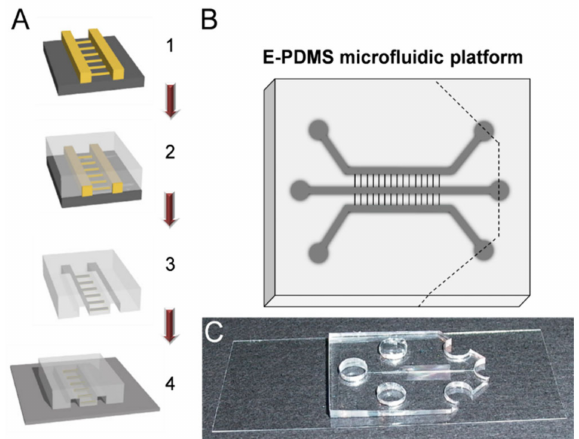
Figure 5. Process flow for fabrication and assembly of microfluidic devices for cell signaling studies. ( A ) Overview of fabrication and assembly process for microfluidic chambers (200 µ m W × 45 µ m H) for cell signaling. Step 1: Microfluidic masters are used for (step 2) replicate molding of PDMS-based microfluidic channels with interconnecting cross channels. Step 3: PDMS replicates are trimmed, and holes punched (upper right diagram) prior to solvent extraction to remove un-cross-linked